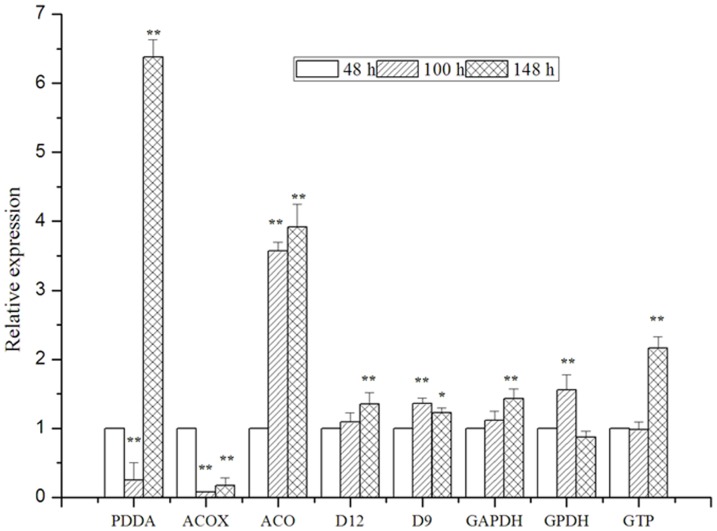
Validation of the gene expression profile by qRT-PCR.PDDA: phospho-2-dehydro-3-deoxyheptonate aldolase, ACOX: acyl-coenzyme an oxidase, ACO: aconitate hydratase, D12: Δ12 fatty acid desaturase, D9: Δ9 fatty acid desaturase, GAPDH: Glyceraldehyde-3-phosphate dehydrogenase, GPDH: Glycerol-3-phosphate dehydrogenase, GTP: phosphoenolpyruvate carboxykinase; *P<0.05, **P<0.01.